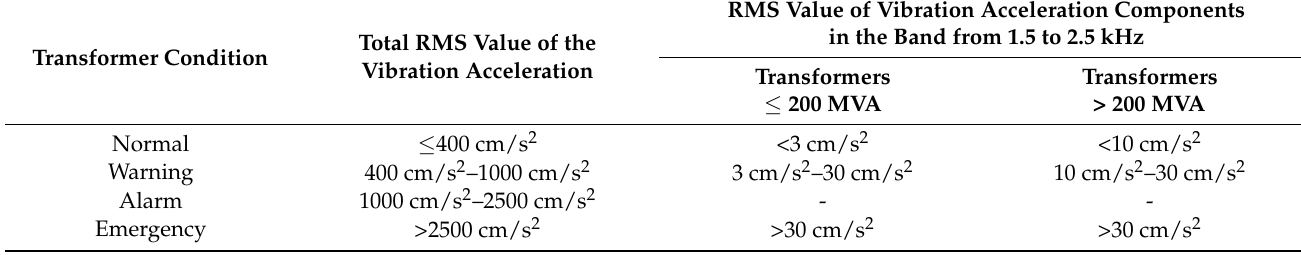
Table 1. Assessment of the technical condition of a transformer based on the RMS value (total and components) of vibration accelerations [17–20].